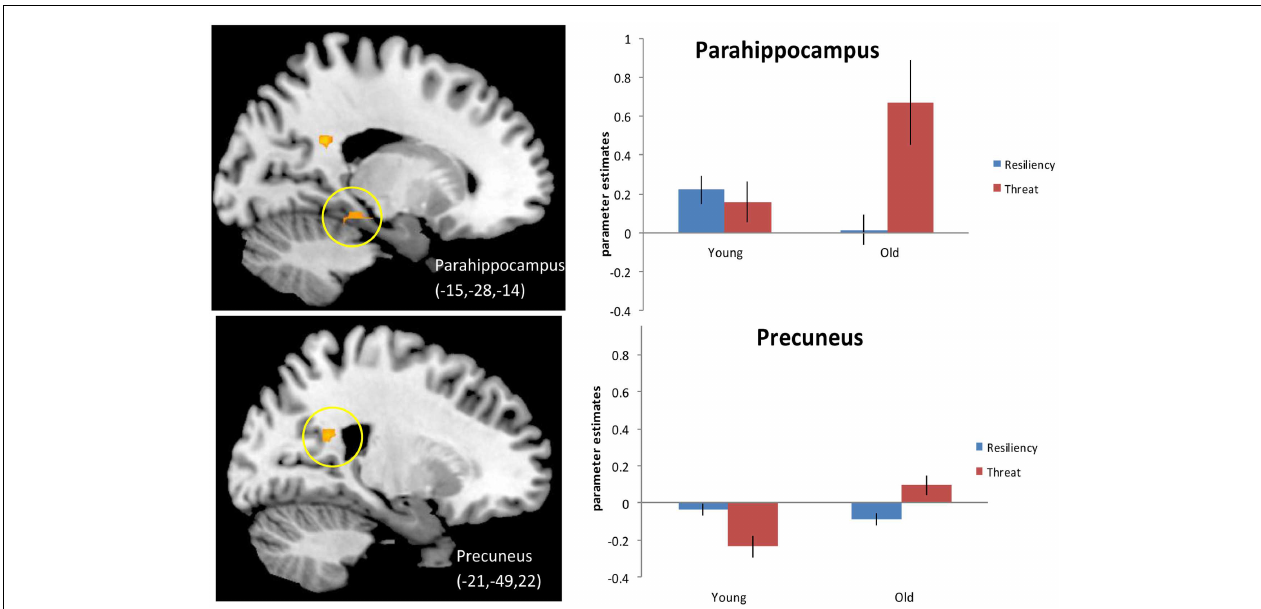
FIGURE 2 |Threat > Resiliency, Older adults > Younger adults .Threshold – p < 0.001, uncorrected, five contiguous voxels. Regions in which the activation for threatening trials (defined as positive denials and negative endorsements) was greater than for resiliency trials (positive endorsements and negative denials) for older adults compared to younger adults. Parahippocampal gyrus for this contrast (Top), the slice displayed corresponds to x =− 18 precuneus activation (Bottom).